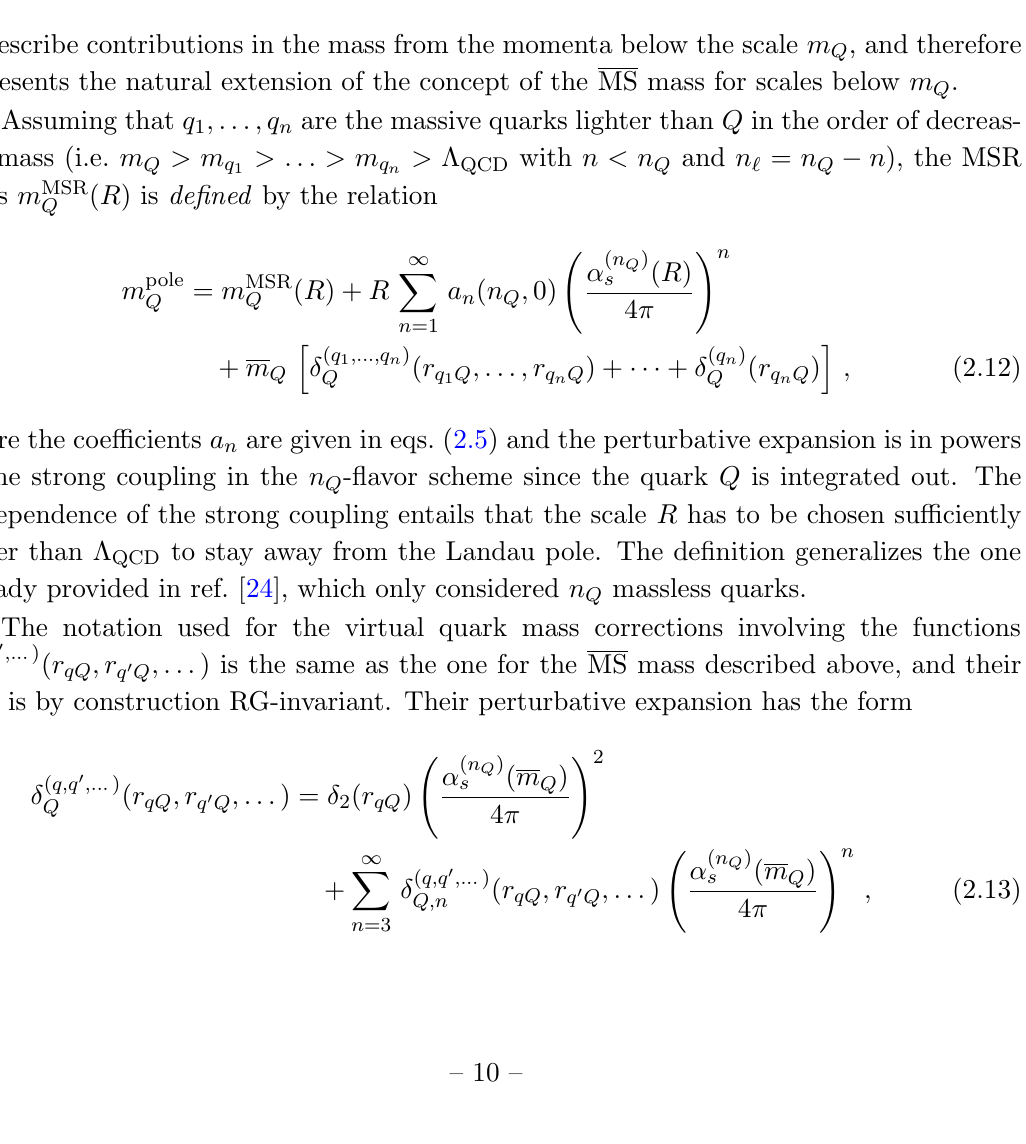
Figure 1 . Graphical illustration of the physical contributions contained in the pole, MSR and MS mass schemes coming from the di(cid:11)erent momentum scales for the case of the top quark. The quark loops stand for the contributions of the virtual massive quark loops contained in the